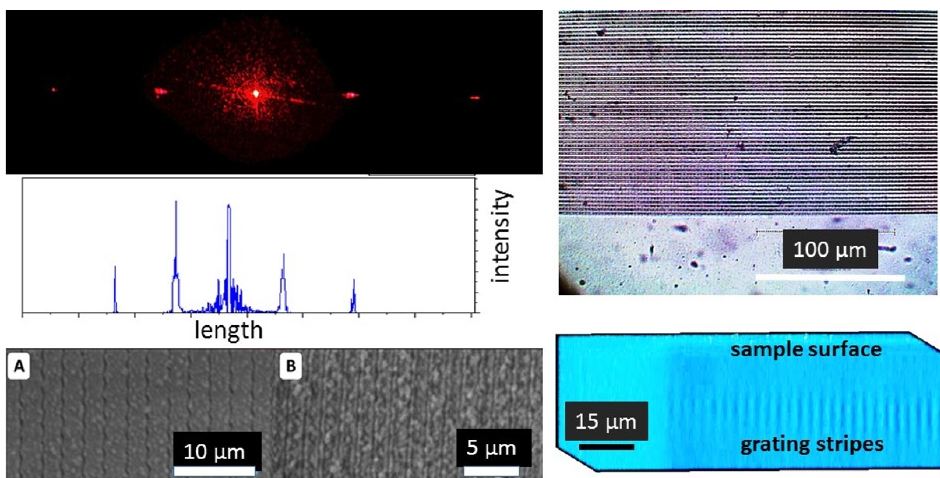
Figure 6. Right side: ( top , middle ) Optical diffraction pattern and its angular spectrum for 633 nm laser light source produced by the bulk 3 µ m diffraction grating in PET sample; ( bottom ) SEM images of bulk diffraction microgratings in PET sample with 3 µ m (( A ), initial) and 1.7 µ m (( B ), shrunk by 2 × ) periods. Left side: ( top ) Optical image of the buried initial diffraction micrograting; ( bottom ) Side-view image of the initial diffraction micrograting under the surface visualized by 3D-scanning confocal Raman/photoluminescence micro-spectroscopy at the 570 nm wavelength.